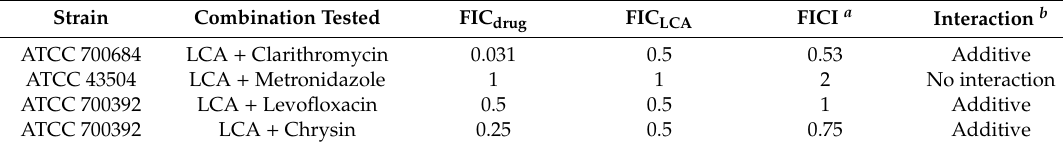
Table 4. Combinatory e ff ect of lithocholic acid (LCA) with several drugs against H. pylori.